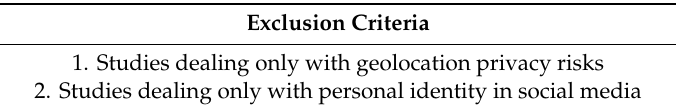
Table 1. Exclusion Criteria (first phase).